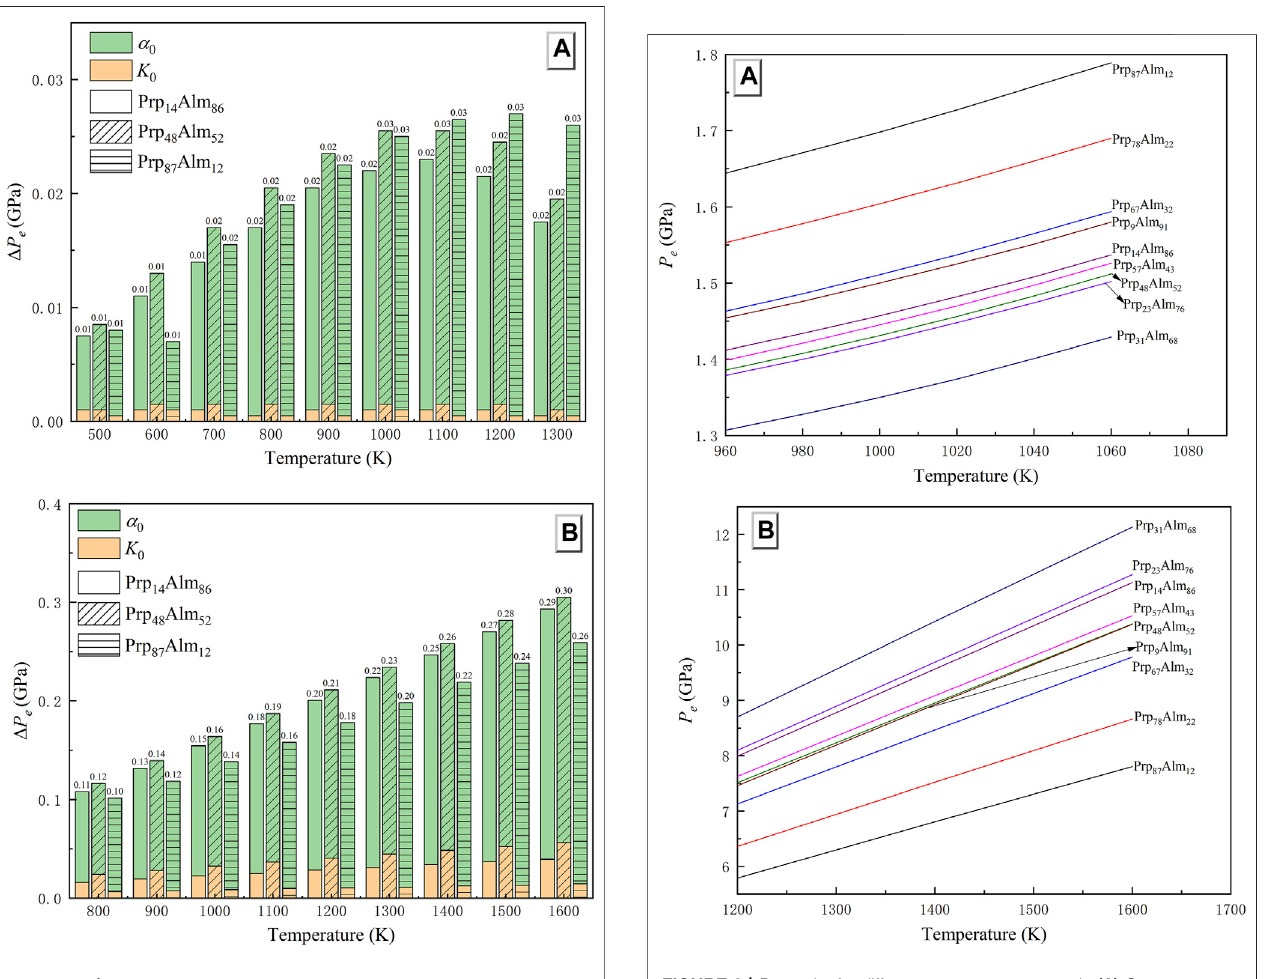
Frontiers in Earth Science |